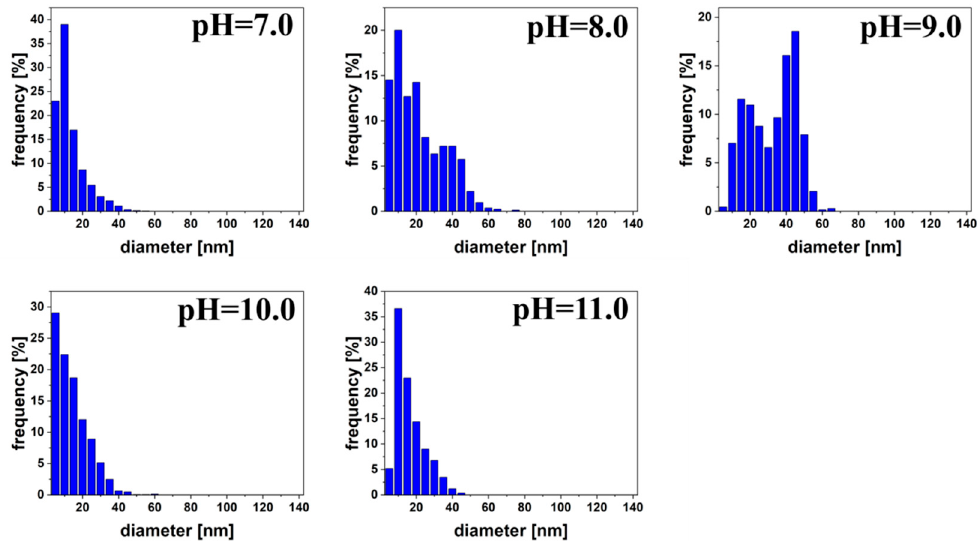
Figure 8. Size distribution of silver quasi-spherical nanoparticles reduced by malic acid at pH 7.0 to 11.0.